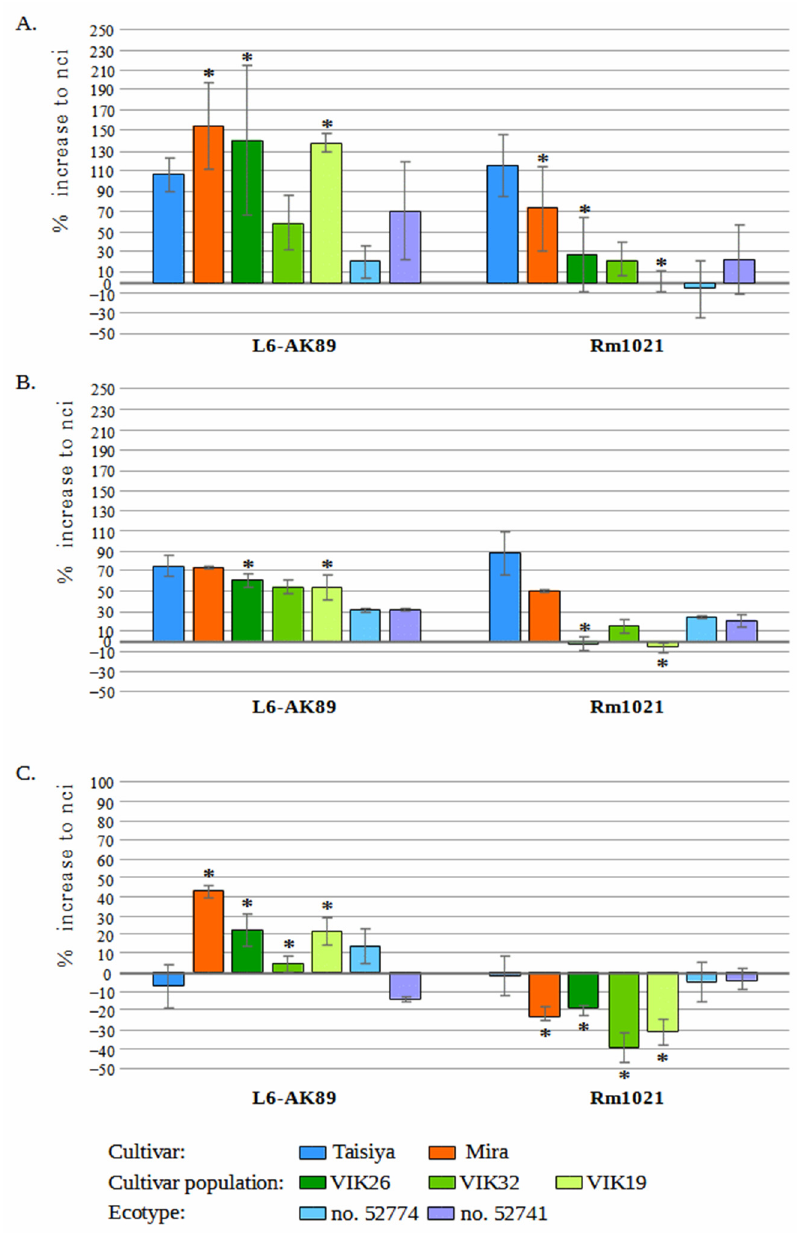
Figure 1. Symbiotic efficiency and morphological parameters of Medicago spp. in symbiosis with Ensifer meliloti L6-AK89 and Rm1021: ( A ) increase in dry mass of plants (% relative to control without inoculation); ( B ) relative change in length of inoculated alfalfa shoots (%); ( C ) relative change in length of inoculated alfalfa roots (%). Error bars represent ± SE. * Significant differences between analyzed strains ( p < 0.05).